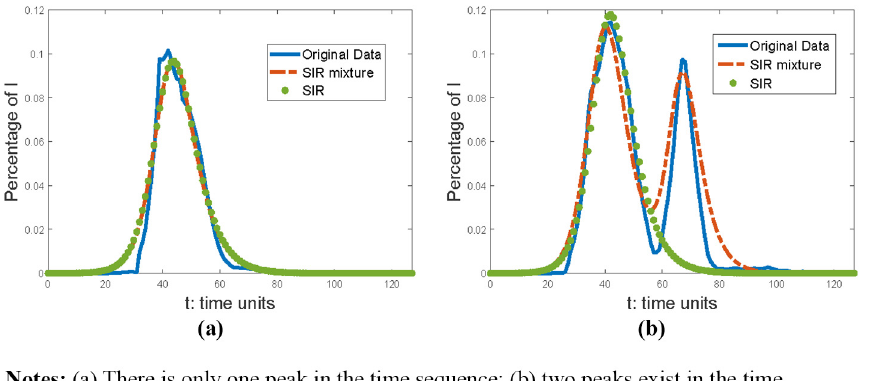
Figure 4. Time sequences of two pieces representative information (blue solid line) and their model fi tting results corresponding to the classic SIRmodel (green dots) and the SIR mixture model (red dash